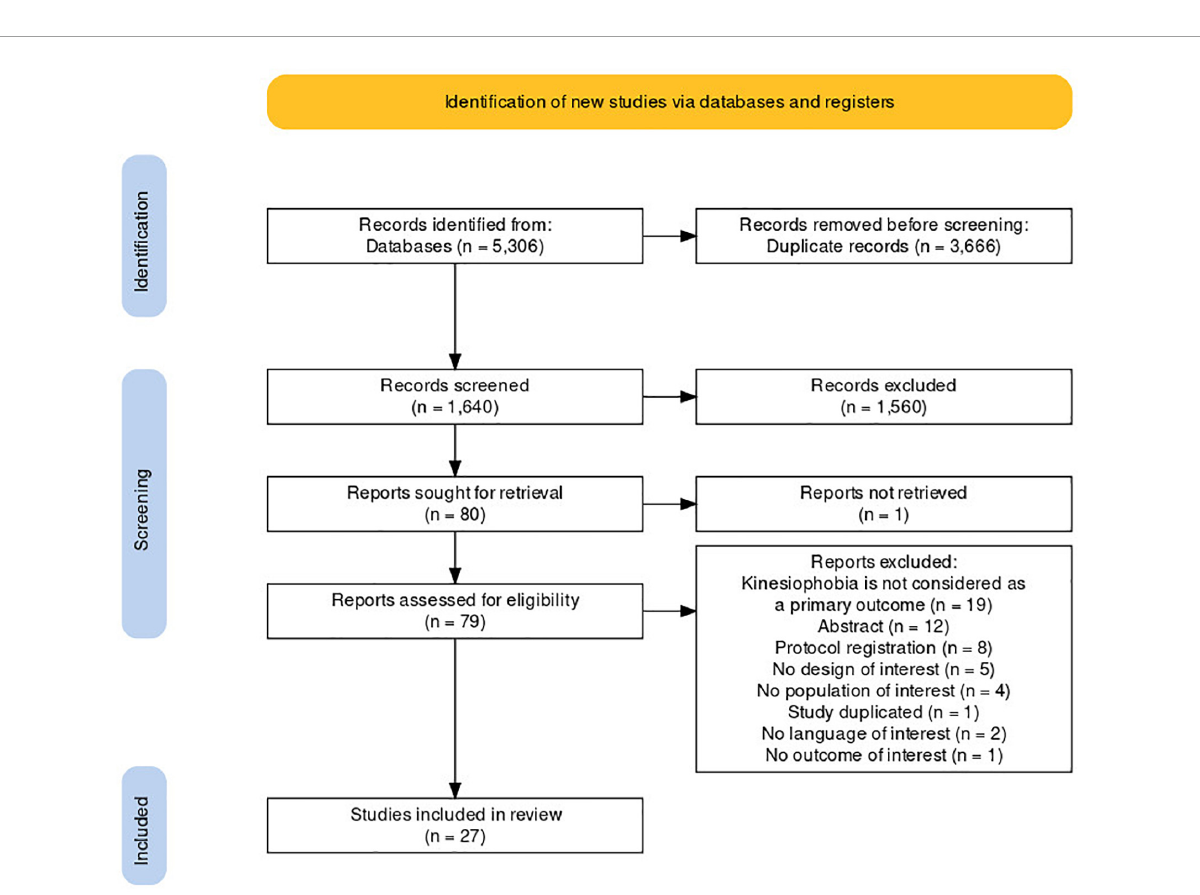
FIGURE2 Flow diagram depicting the flow of information through the various stages of the review. This figure was created by using a customizable online tool flow diagram that adheres to PRISMA 2020 standards (Haddaway et al.,